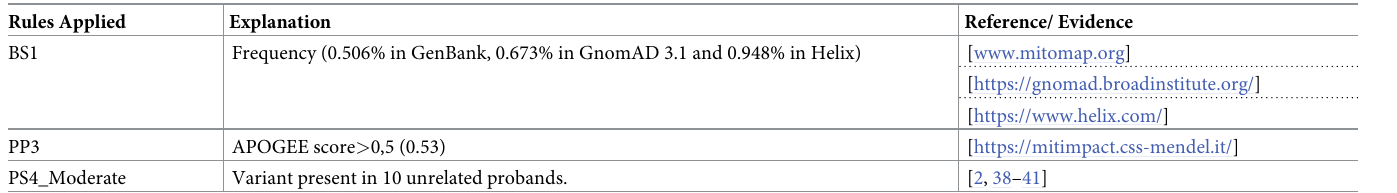
Table 2. Summary of rules applied m.11253T > C p.Ile165Thr in MT-ND